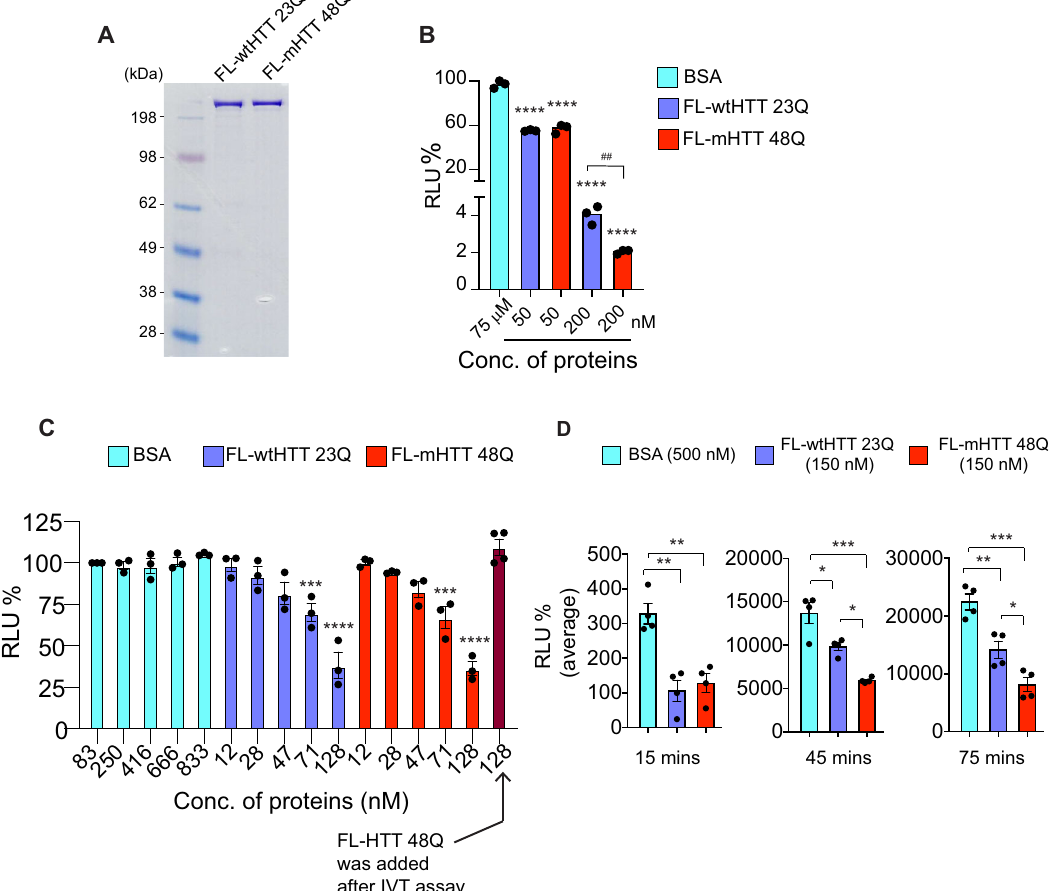
Fig. 3 mHTT inhibits protein synthesis in vitro. A Coomassie gel showing FL-wtHTT 23Q (250 ng) and FL-mHTT 48Q (250 ng), n = 3 independent experiments. B Shows the percentage of relative luciferase unit (RLU) in presence of an indicated concentration of recombinant FL-wtHTT and FL-mHTT. HTT proteins normalized to the maximum luminescence in BSA (75 μ M). Data are mean ± SEM ( n = 3 independent experiments). **** P < 0.0001 by one- way ANOVA followed by Tukey ’ s multiple comparison test. ## P < 0.01 by two-tailed Student ’ s t test. C In vitro translation (IVT) assay in presence of different concentrations of recombinant FL-wtHTT 23Q and FL-mHTT 48Q or BSA. Bar graphs depict the percentage of relative luciferase unit (RLU) normalized to the maximum luminescence in BSA (83 nM). Data are mean ± SEM ( n = 3 independent experiments). *** P < 0.001, **** P < 0.0001 by one- way ANOVA followed by Bonferroni ’ s multiple comparisons test. D Shows luciferase activity at 15, 45, and 75 min of IVT reaction with 150 nM recombinant FL-wtHTT 23Q and FL-mHTT 48Q proteins or BSA (500 nM). Data are mean ± SEM ( n = 4 independent experiments). * P < 0.05, ** P < 0.01, *** P < 0.001, by one-way ANOVA followed by Tukey ’ s multiple comparison test. Exact P values are reported in the Source Data fi le. Source data are provided as a Source Data fi